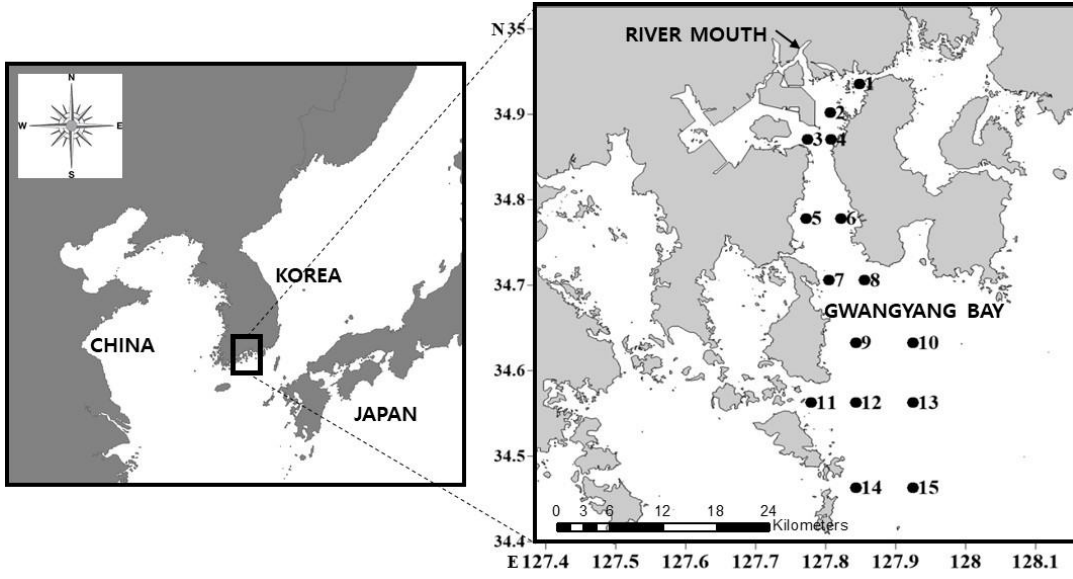
Figure 1. Map of the study sites (black closed circles) in Gwangyang Bay.